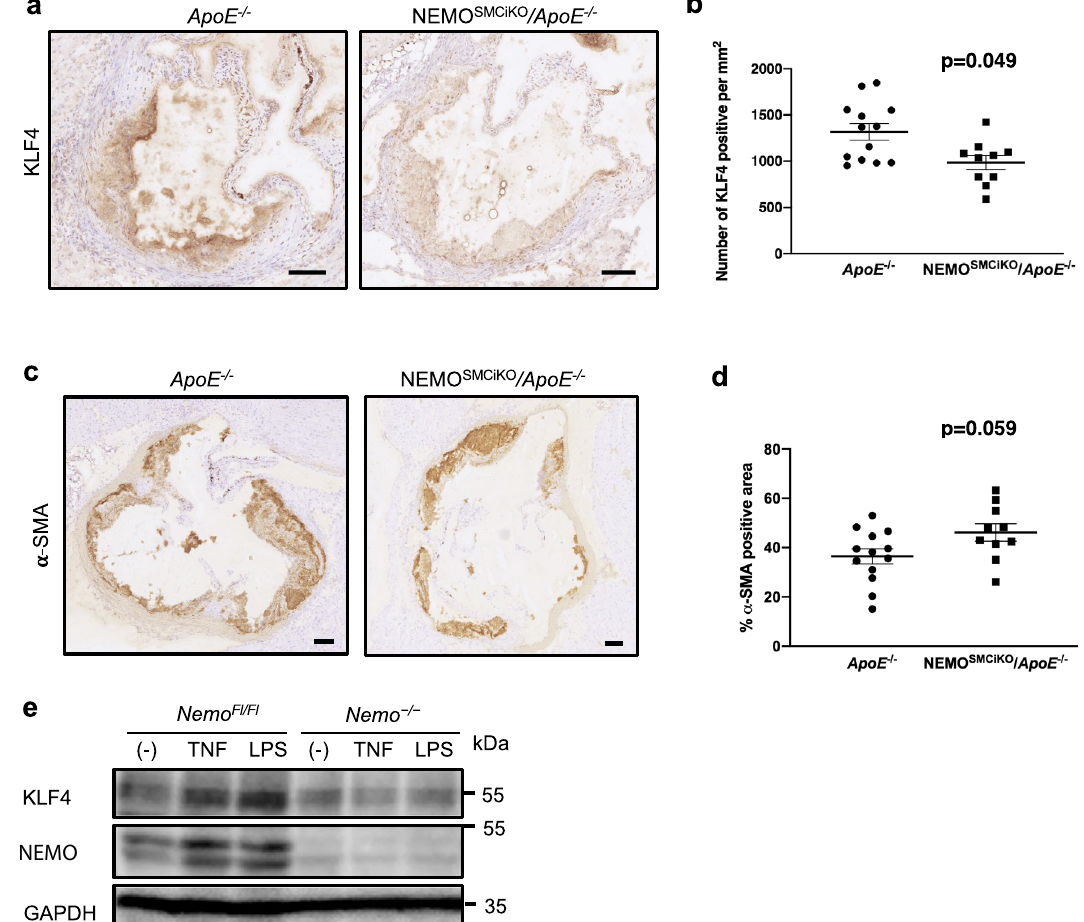
Figure 5. Deletion of NEMO in smooth muscle cells inhibits their phenotype switching. Representative pictures from immunostainings of atherosclerotic lesions of ApoE − / − or NEMO SMCiKO / ApoE − / − mice with antibodies against KLF4 ( a ) and α-SMA ( c ). Scale bars = 0.1 mm. Graph showing quantification of KLF4 positive cells ( b ) and α-SMA content ( d ) in the lesions of ApoE − / − (n = 13) or NEMO SMCiKO / ApoE − / − (n = 10) mice (Mann–Whitney test). ( e ) Cultured smooth muscle cells were stimulated with TNF (1 ng/ml) and LPS (10 ng/ ml) or left unstimulated in starved medium for 48 h. Total protein lysates of smooth muscle cells were subjected to western blot analysis of KLF4 and NEMO protein expression. Glyceraldehyde 3-phosphate dehydrogenase (GAPDH) was used as a loading control. Uncropped blots are presented in Supplementary Fig.